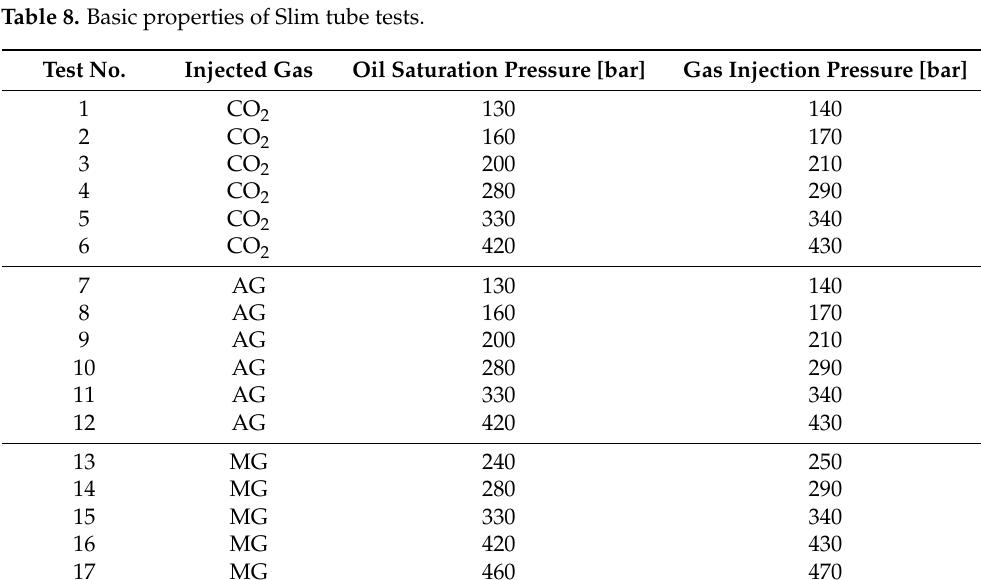
Table 8. Basic properties of Slim tube